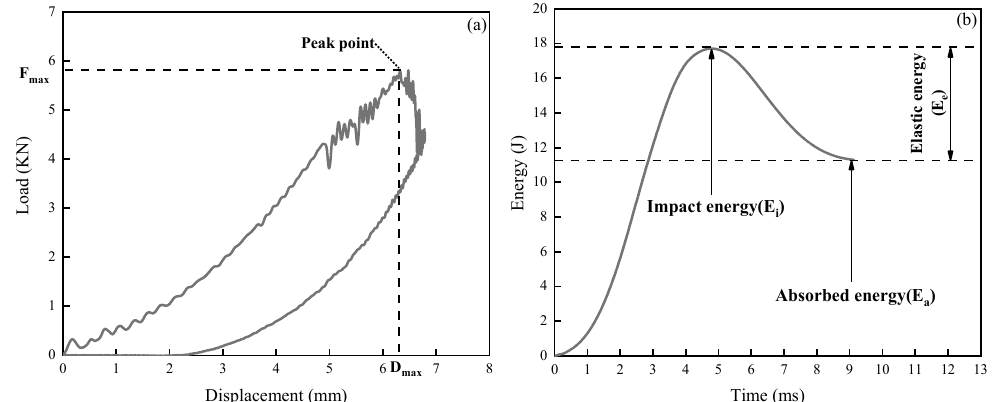
Figure 6. Typical load–displacement ( a ) and energy–time ( b ) curves of toughened laminated composite.